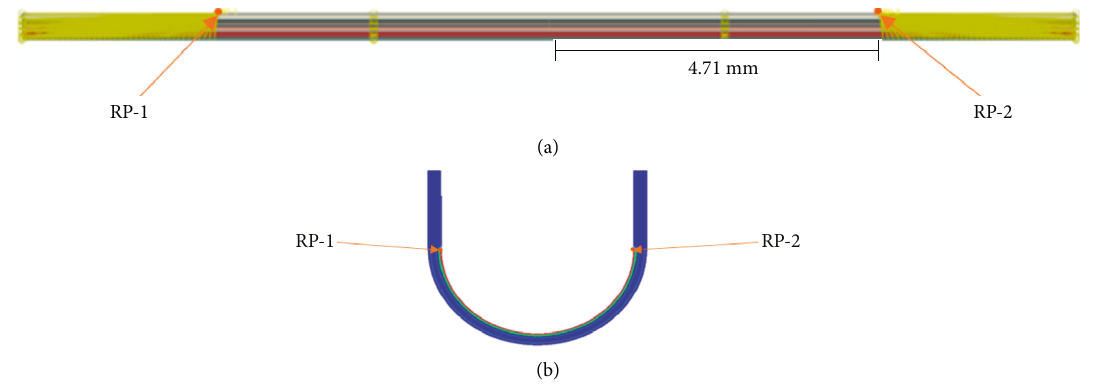
Figure 2: (a) Before the module is bent. (b) After the module is bent. Composite